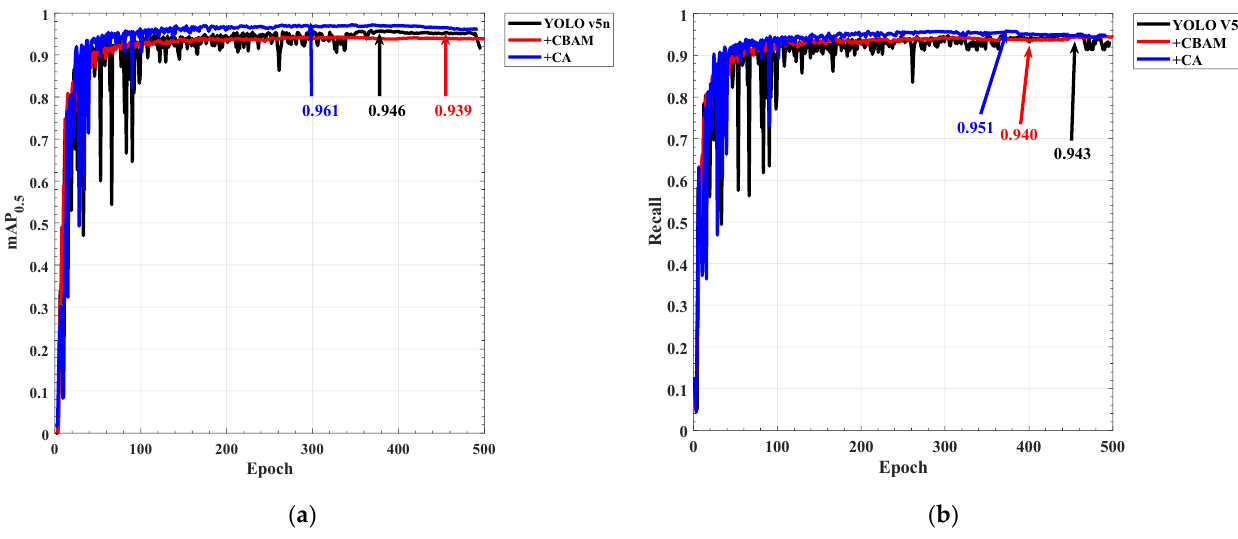
Figure 10. Comparison of network training results: ( a ) Mean of Average Precision; ( b ) Recall.